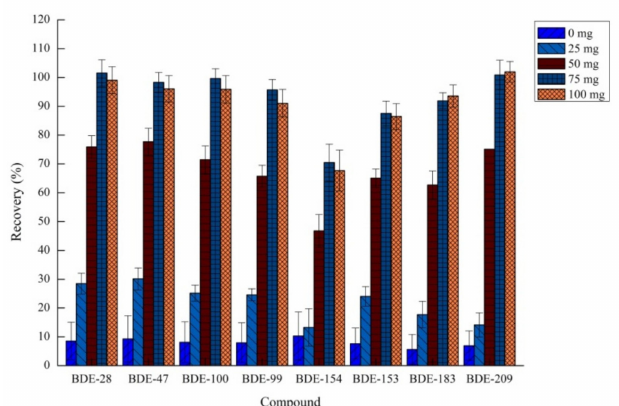
Figure 3. Effect of amount of sodium bicarbonate on recovery ( n = 3).